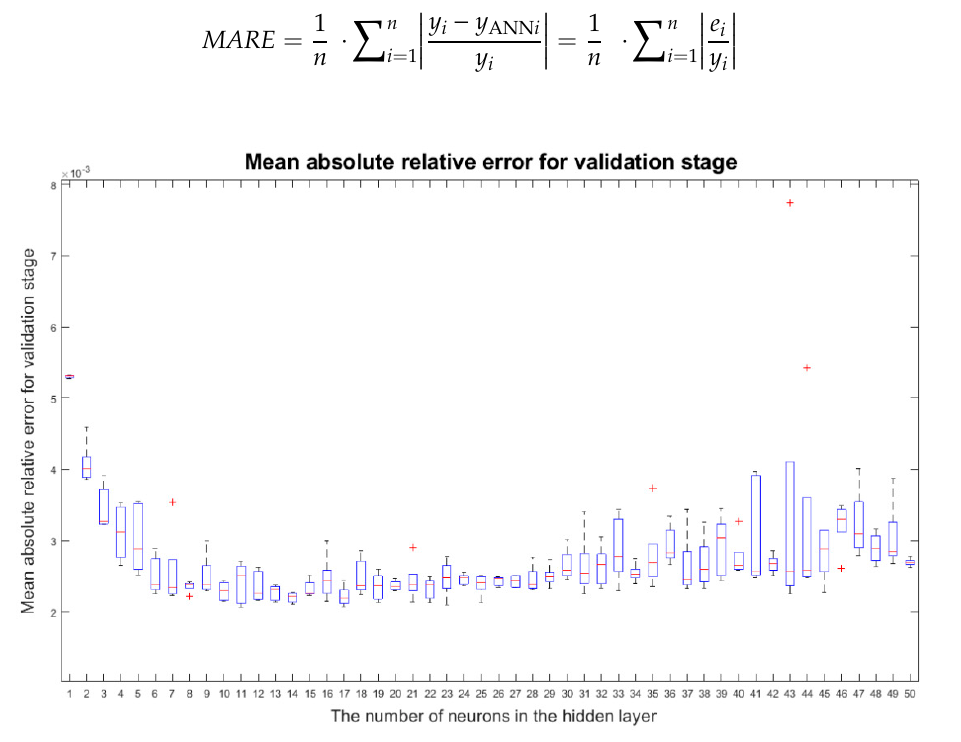
Figure 4. Mean absolute relative error obtained for the neural network structure with a certain number of neurons in a hidden layer.